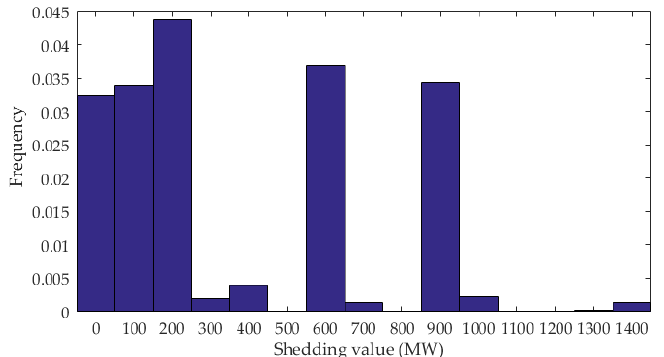
Energies 2017 , 10 , 895